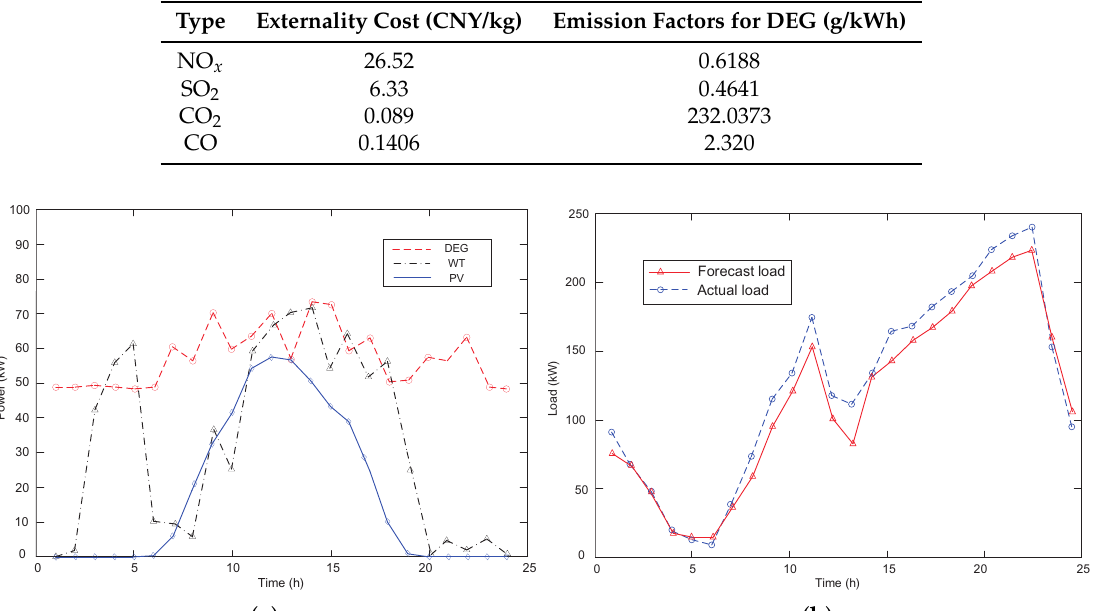
( b ) Figure 6. Thepredictedpowerofthedistributedsystemandloaddemandinthemicrogrid. ( a )Predictionpower. ( b ) Load demand. Performance of the proposed PSO-OGSA has been validated on the five benchmark functions, and the convergence rate of the PSO-OGSA is superior to the other two methods.To evaluate the performance of the proposed PSO-OGSA for finding the optimal solution of the MOOD problem. The PSO-OGSA, PSO and basic GSA are used to solve the MOOD problem for this microgrid. The algorithm parameter settings, computer configurations and programming software in this section are the same as those of Section 4.1. For all simulation experiments, the population size is set to 50, and the maximum iteration number is set to 1000.